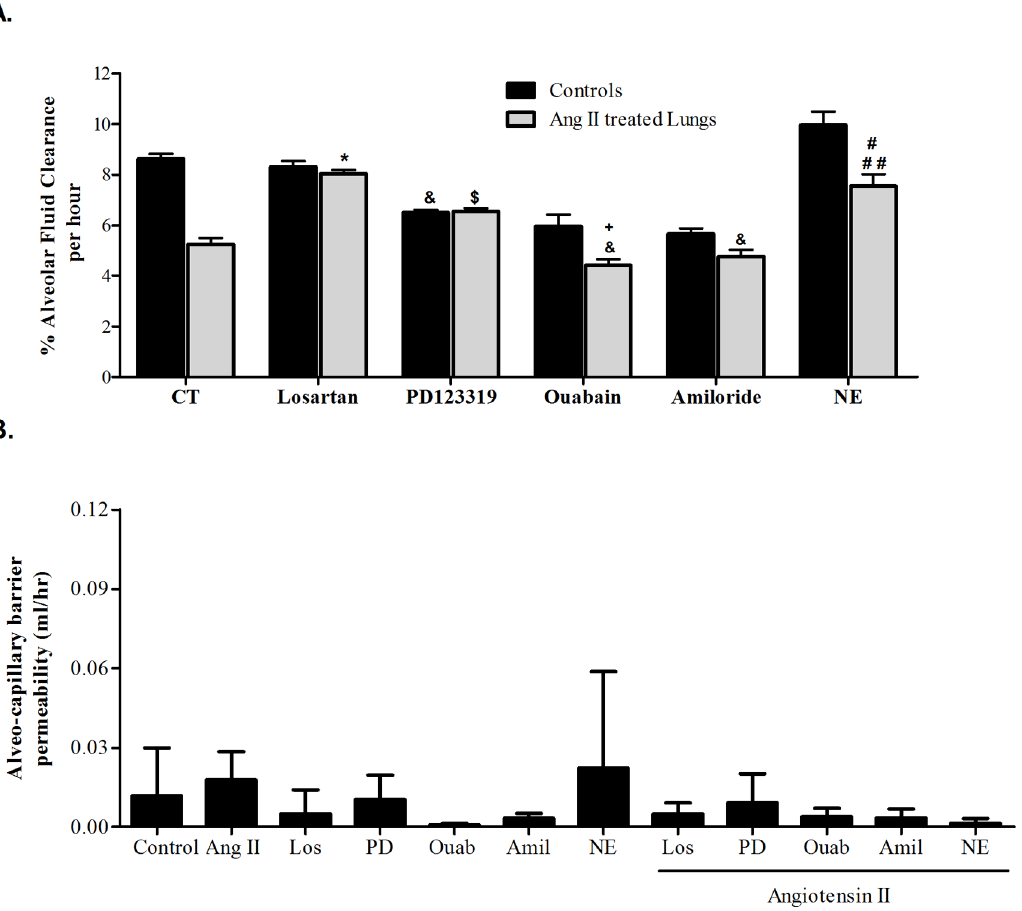
Fig 2. Different interventions effect on AFC. (A) Losartan restored Ang II effect on AFC from 5.25% ± 0.23 to 8.1% ± 0.13. AFC was not different in both losartan treated groups. * P < 0.001 As compared to control group treated with Ang II. PD123319, AT 2 receptor antagonist, decreased AFC in both AngII treated (n = 4) and untreated groups (n = 4) (6.54% ± 0.2 and 6.51% ± 0.2 respectively). $ P < 0.05 as compared to Ang II group, & P < 0.001 as compared to control group. Ouabain, the Na,K-ATPase blocker, significantly inhibited AFC in both control and Ang II treated rat lungs (5.9% ± 0.4 and 4.4% ± 0.2 respectively). + P < 0.05 as compared to control rat lungs treated with ouabain alone. Amiloride, the sodium channel blocker, significantly reduced AFC in both control and Ang II treated rats as compared to untreated lungs (a 5.6% ± 0.2 and 5.01 ± 0.2 respectively). However, AFC was similar in the two Amiloride treated groups. Activating the adrenergic pathway by norepinephrine 10 -6 M increased the clearance percentage to 14.12% ± 1.8, when compared to control 8.6% ± 0.19. But when Ang II was also added, NE effect was abolished (7.3% ± 0.6). # P < 0.05 as compared to control rat lungs treated with norepinephrine alone. ## P < 0.0001 as compared to AngII group. CT — Control. Ang II — Angiotensin II. NE — Norepinephrine. The bars represent mean ± SEM. (B) The albumin movement across the alveolar-capillary barrier did not differ significantly among the study groups indicating that the barrier was intact. CT —